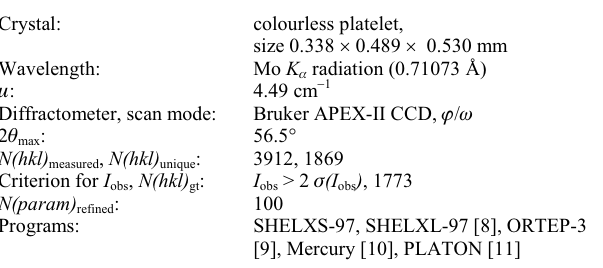
Table 1. Data collection and handling.